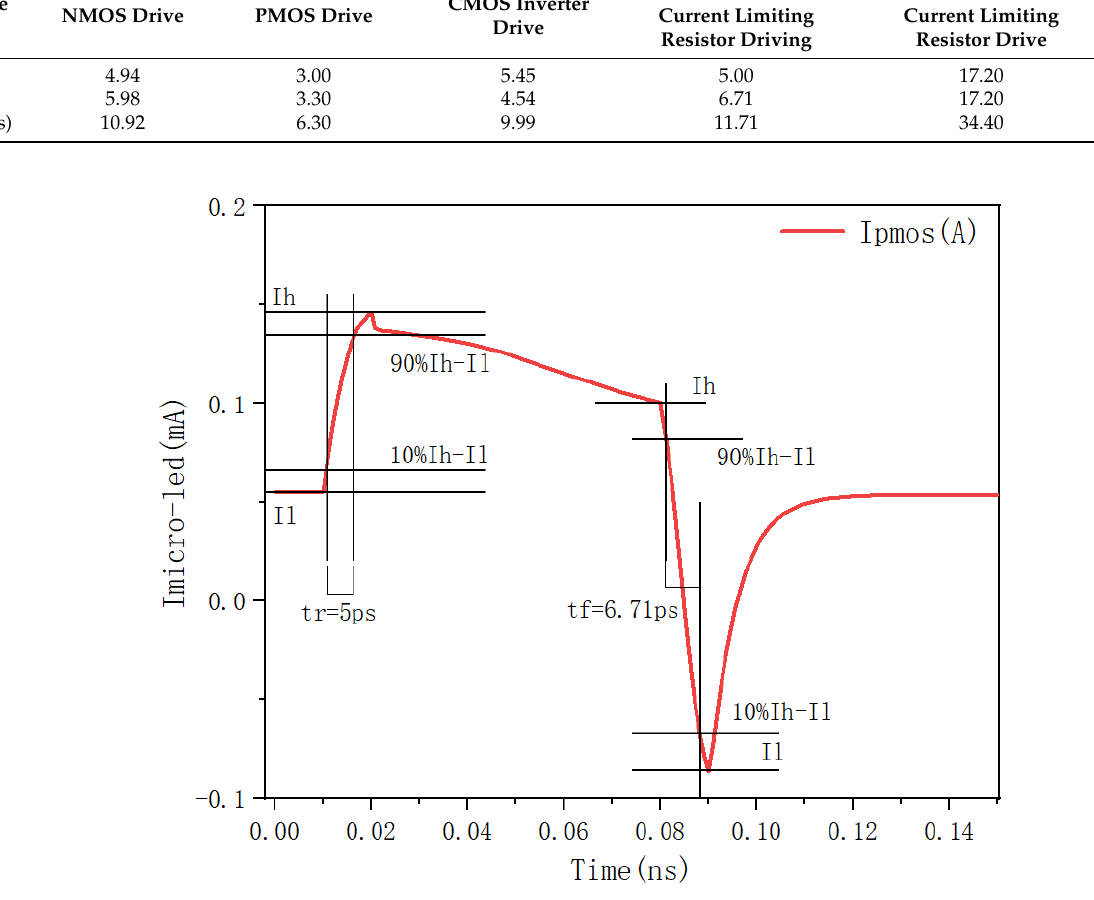
Figure 18. Analysis of rising time and falling time of the output current curve of the micro-LED driven by the CMOS inverter, connected with a current limiting resistor with time.